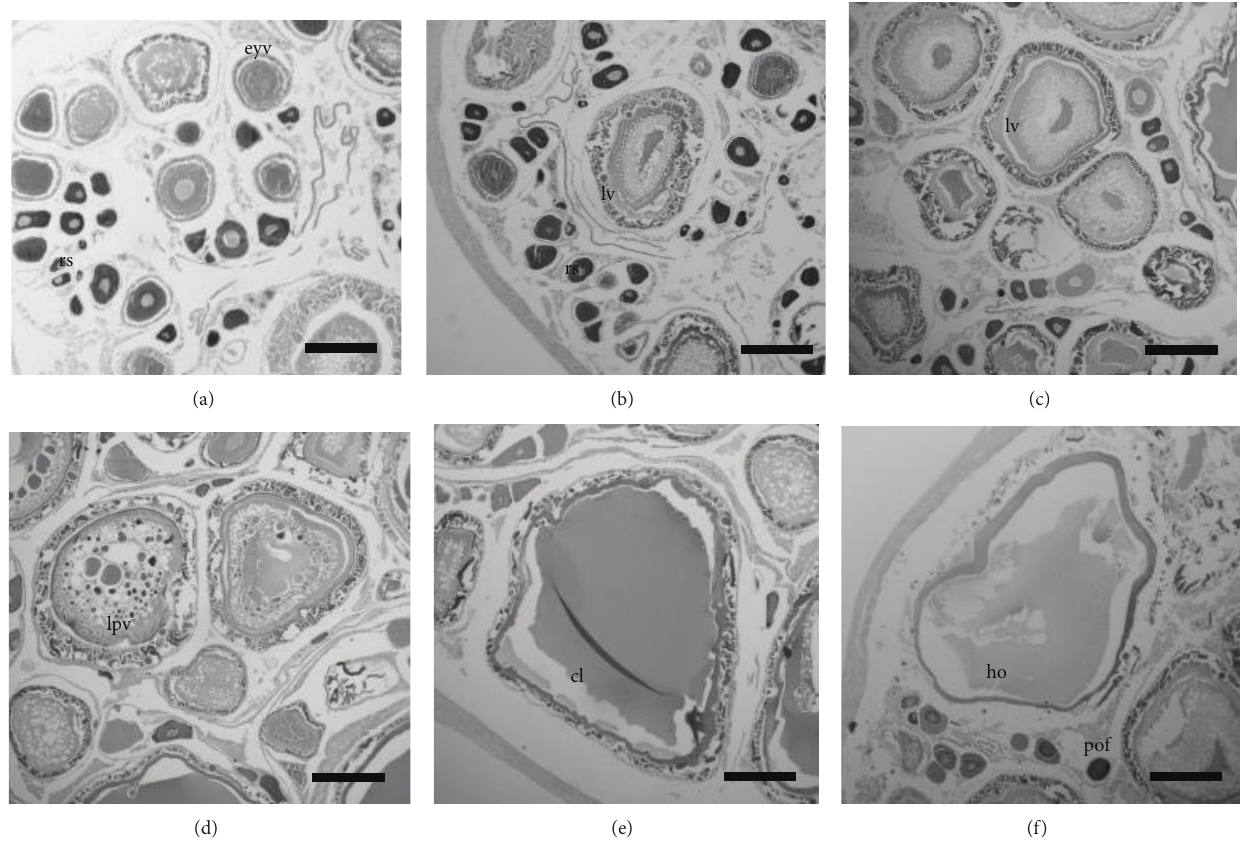
Figure 4: Histological aspects of oocyte development stages of H. brasiliensis : (a) perinucleolus stage or reserve stock (rs) and early yolk vesicle (eyv); (b) lipid vitellogenesis (lv) and rs; (c) lv (d) lipid and protein vitellogenesis (lpv); (e) oocytes with complete vitellogenesis (cl);